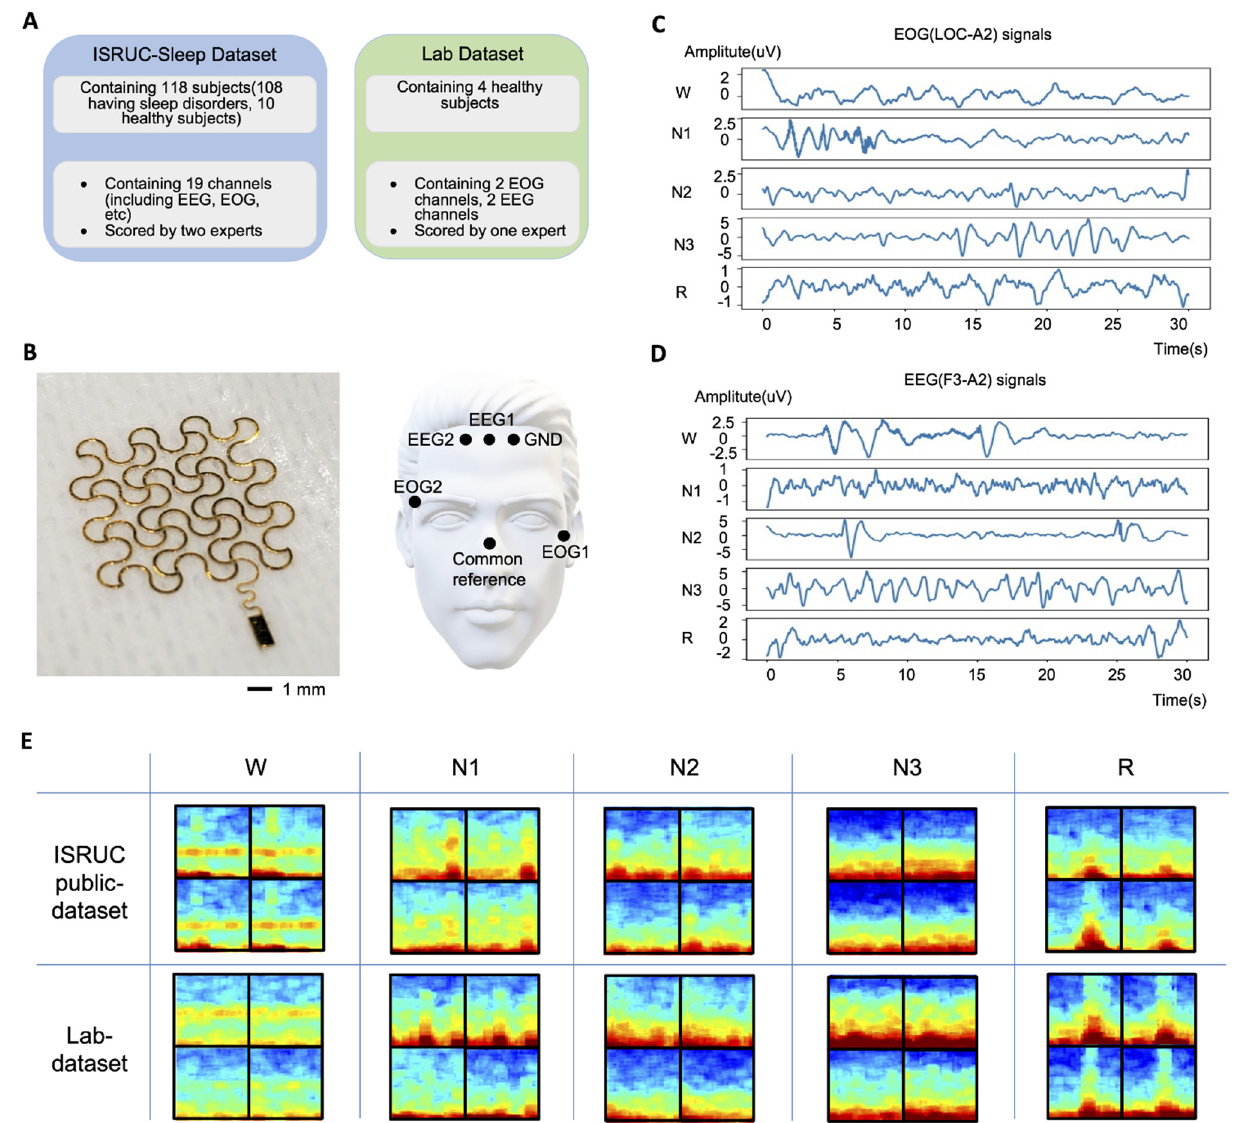
Figure 1. Overview of a public dataset (ISRUC) and the measured lab dataset. ( A ) Detailed infor- mation of both datasets. ( B ) Data recording system using nanomembrane bioelectrodes (left) and the sensor mounting locations (right) were the upper center of the forehead (EEG1 and EEG2) to measure two-channel EEG, one electrode on the lower-left corner of the left eye (EOG1) to measure two-channel EOG, and another electrode on the upper-right corner of the right eye (EOG2). ( C ) Measured EOG signals of five different sleep stages: W, N1, N2, N3, and R. ( D ) Measured EEG signals of five different sleep stages: W, N1, N2, N3, and R. ( E ) Examples of multi-taper spectrograms of both the ISRUC public and the lab datasets with five sleep stages. From top-to-bottom and left-to-right, the spectrograms show channels F3-A2, F4-A1, EOGL, and EOGR of the public dataset, and channels EEG1, EEG2, EOG1, and EOG2 of the lab dataset.